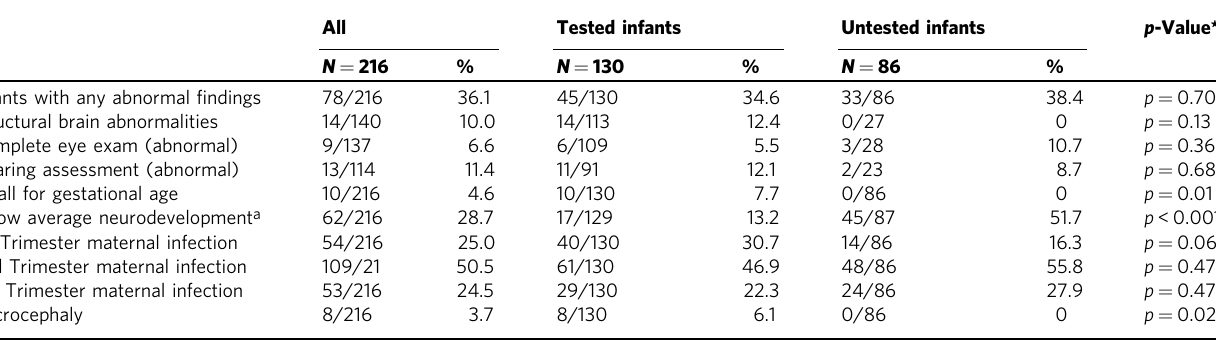
Table 1 Frequency of abnormal fi ndings among in utero ZIKV-exposed infants according to ZIKV postnatal testing status. All Tested